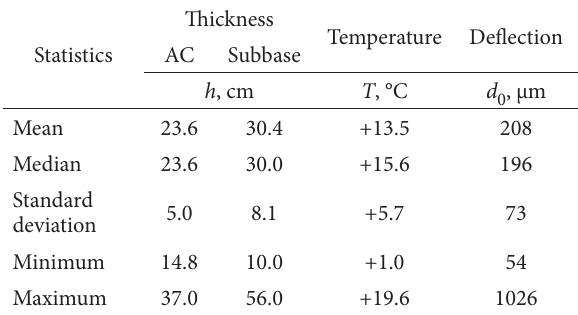
Table 1. Statistical values of training set elements